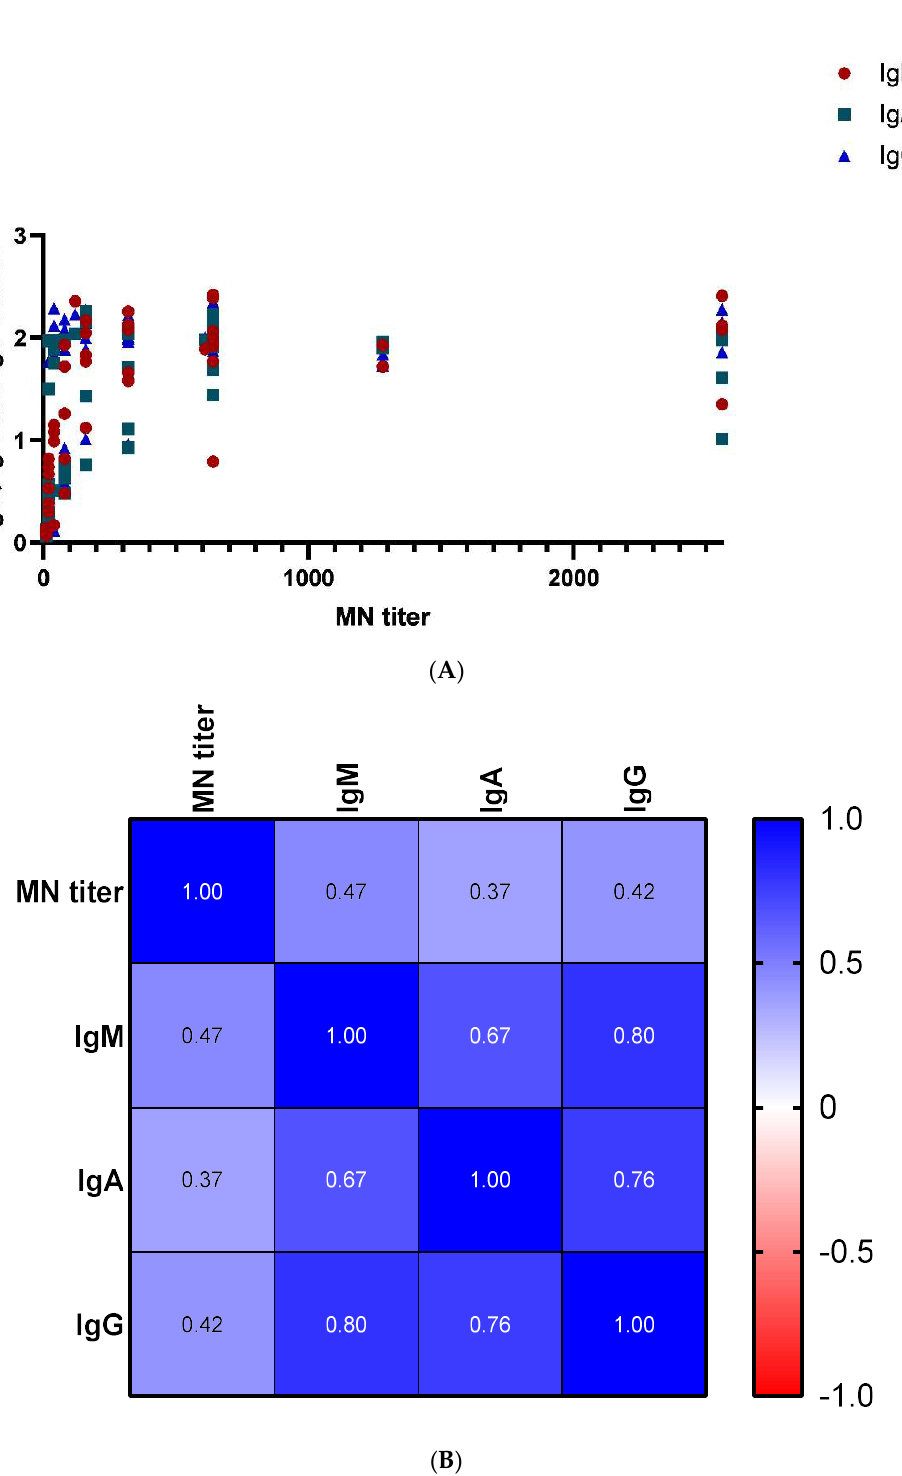
Figure 2. ( A ) Plotting of MN titers versus ELISA IgM, IgA, and IgG values. ( B ) Pearson’s test matrix: p values 0.001, 0.009, and 0.003, respectively.